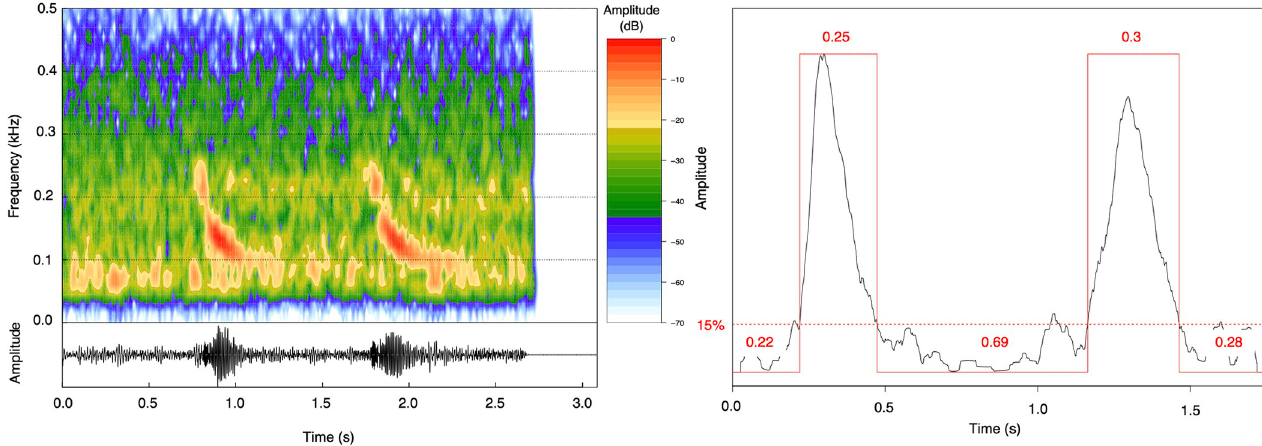
Fig 2. A) Spectrogram of the Bio-duck “A2”, 1125 points FFT, 85% overlap, Hanning window. B) Waveform of the Bio-duck “A2” showing the threshold of the amplitude detector in 15% with an SNR = 18. The figure shows how the detector measures the 1st Pulse, the Inter pulse interval, the 2nd Pulse and the Total